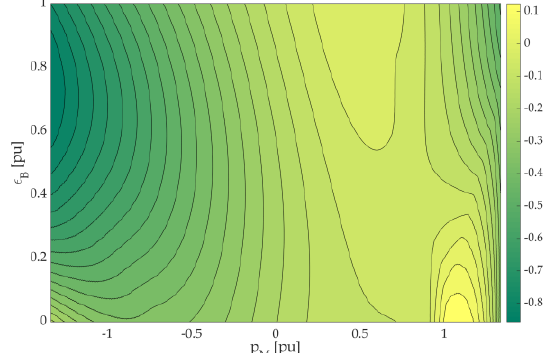
Figure 13. Differences between optimal φ loci (in $/h) on the ( p M , ε B ) plane achieved by A-EMS for v B = 0 and S-EMS.